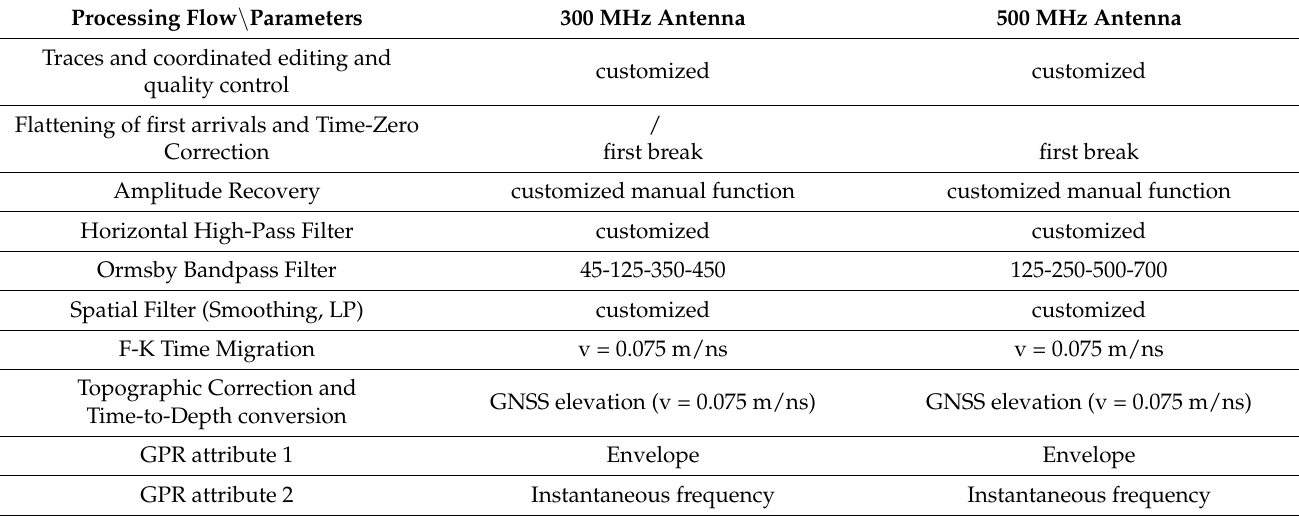
Table 5. Processing flow and detail of parameters used for the experimental GPR